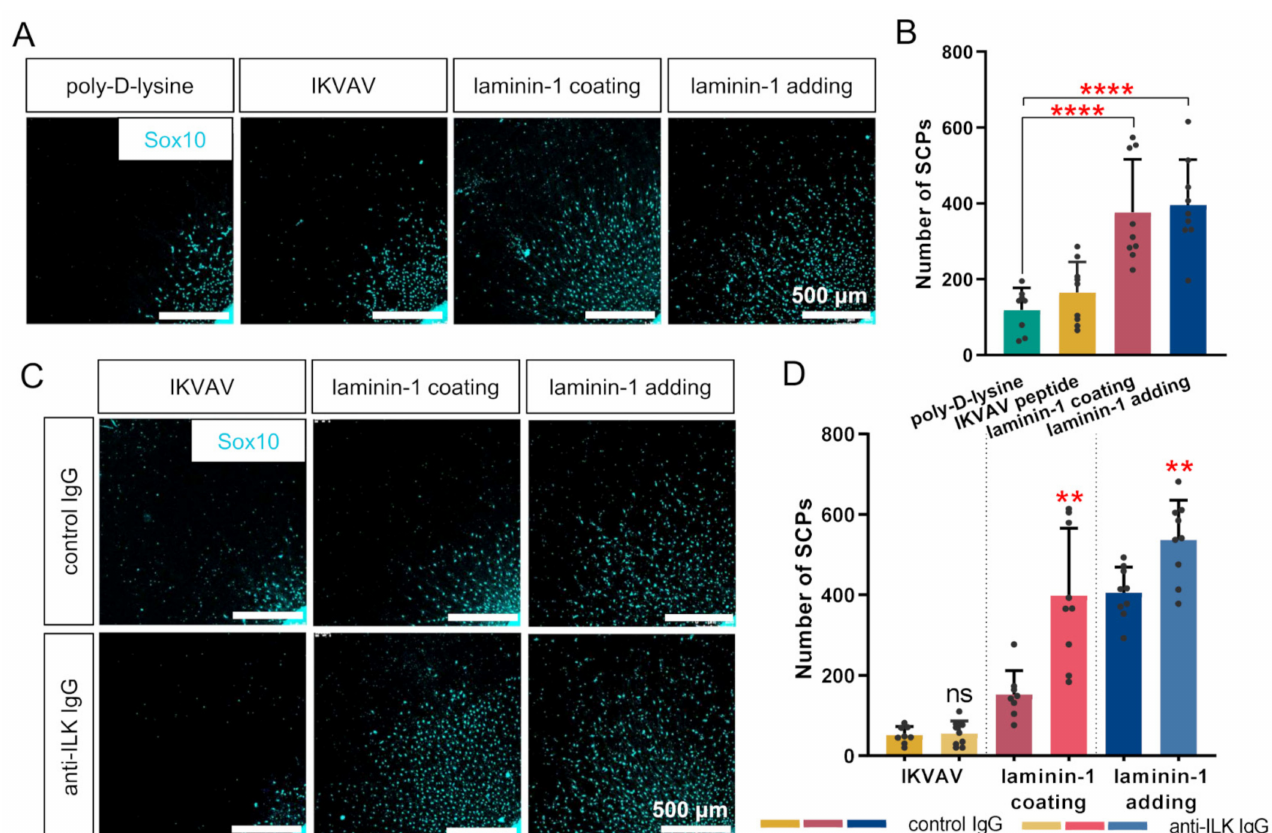
Figure 7. ILK is important for the number of SCPs migrating from DRG explant when cultured on laminin-1. DRG were cultured on a laminin-1-coated surface or with addition to the medium of IKVAV peptide or laminin-1 for 48 h. Additionally, control or anti-ILK antibodies were added to the medium. The number of SCPs was calculated based on immunostaining against Sox10. ( A ) Representative images showing the nuclei of SCPs present in DRG culture. ( B ) Quantitative analysis of the number of SCPs migrating along axons for DRG; p ≤ 0.0001 (****); ( n = 9); ( C ) Images showing the nuclei of SCPs present in DRG culture after disrupting ILK’s function using anti-ILK antibodies; ( D ) Quantification of the number of SCPs migrating along axons for DRG cultured with antibodies against ILK; p ≤ 0.01 (**); ns—not significant; ( n = 9). All quantitative data are presented as mean ± SD. The number of SCPs was measured for four sides of each analyzed DRG and then averaged. Individual points represent averaged values obtained from the analysis of each